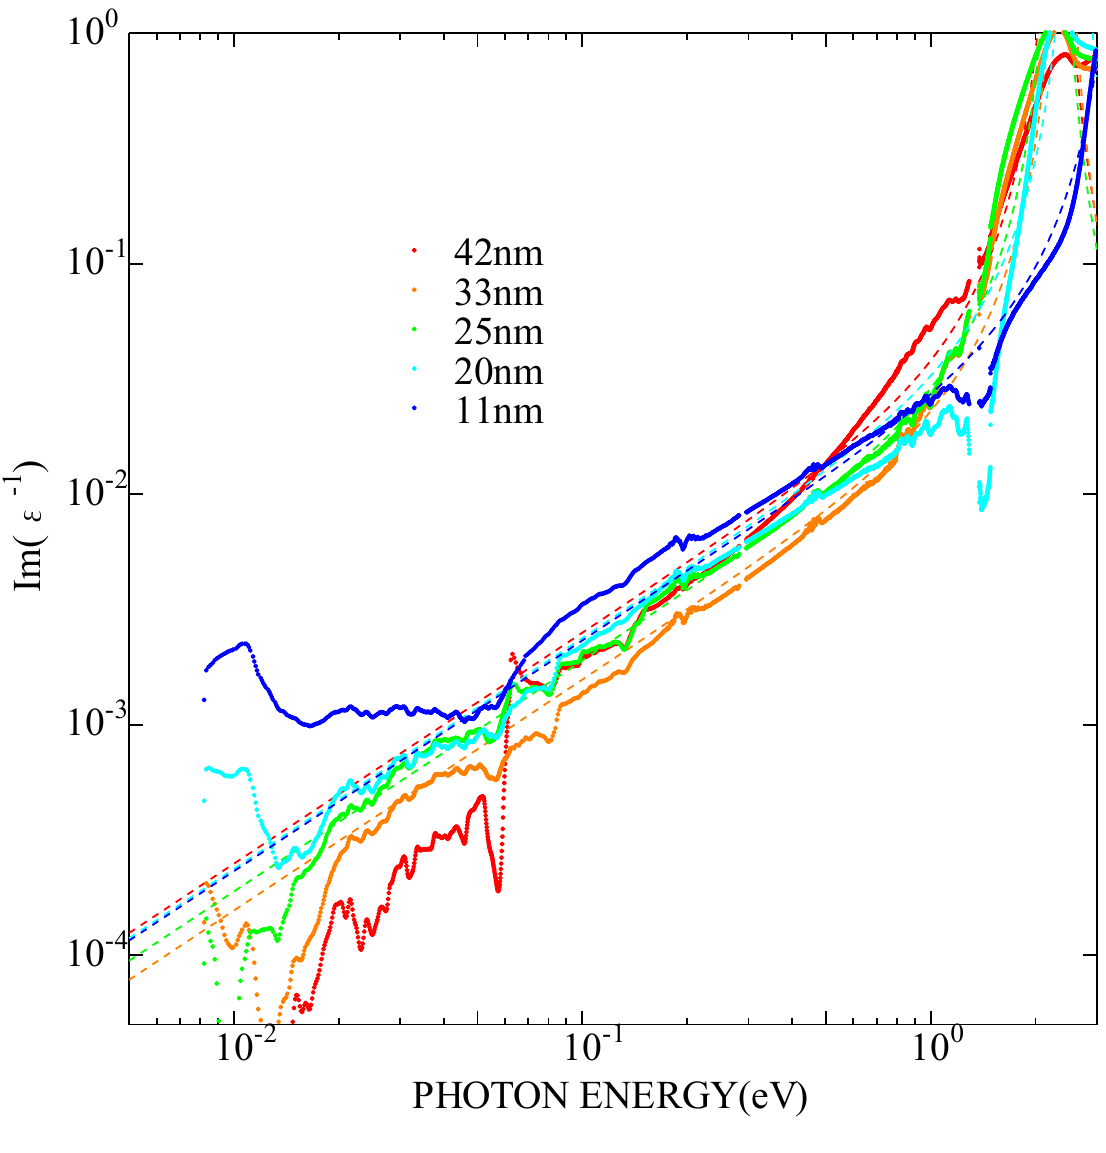
Figure 6: Drude curve fitting of the energy loss function spectra of NPG membranes on quartz substrates. Dashed lines show fitting curves for each pore size